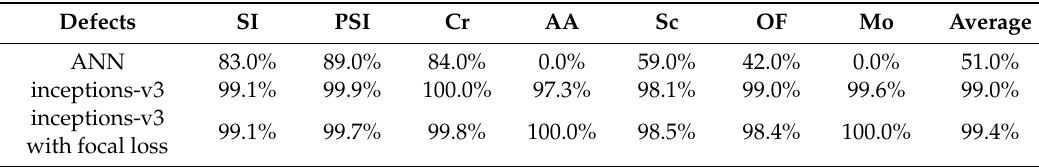
Table 3. Classification accuracy of Artificial Neural Networks (ANN), inceptions-v3, and inceptions-v3 with focal